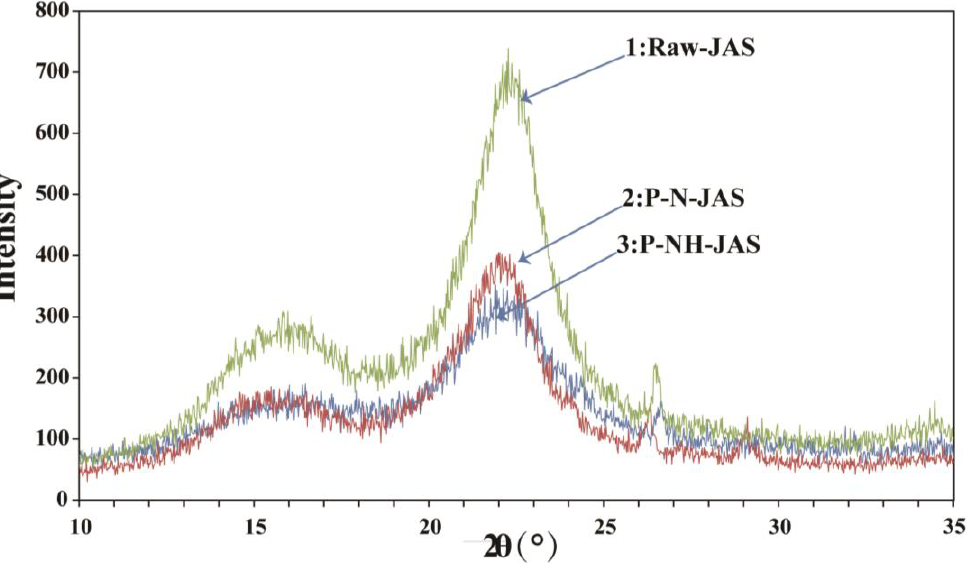
Figure 5. Comparison of X-ray diffraction patterns. P-N JAS: NaOH-pretreated JAS, P-NH JAS: CO-pretreated JAS.